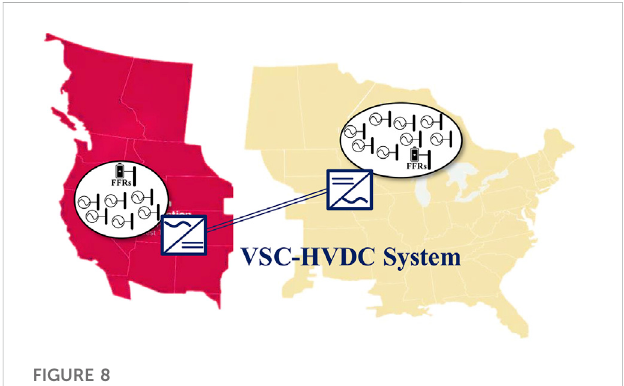
FIGURE 8 Con fi guration of the NAG system.